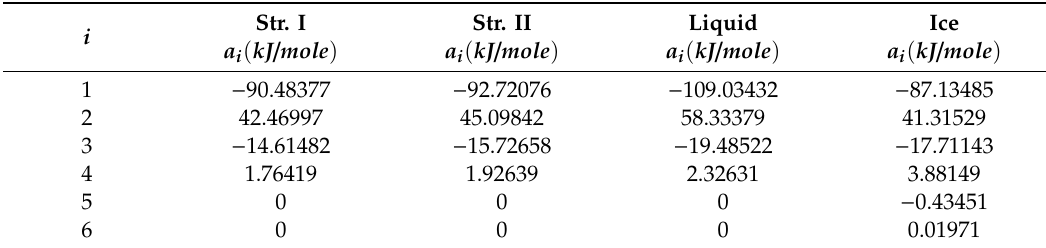
Table 1. Coe ffi cients a i for chemical potential of water in various phases; µ H = 647.096 K. T C H 2 O